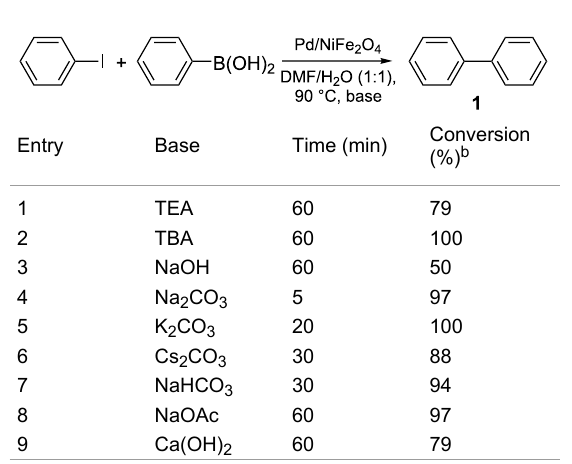
Table 2: The effect of various bases on the Suzuki coupling reaction a .